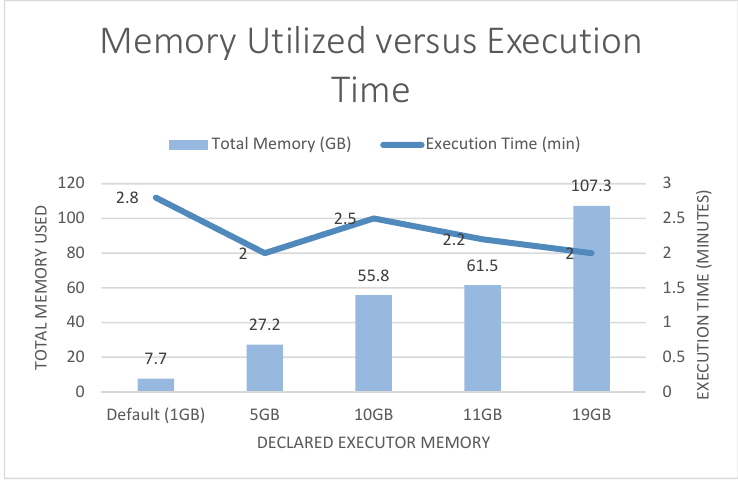
Figure 4. Executor Memory versus Execution Time and Total Memory.